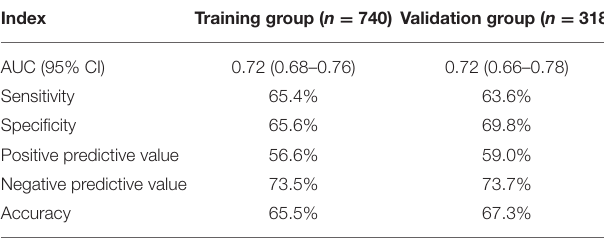
TABLE 3 | Accuracy of the nomogram in predicting